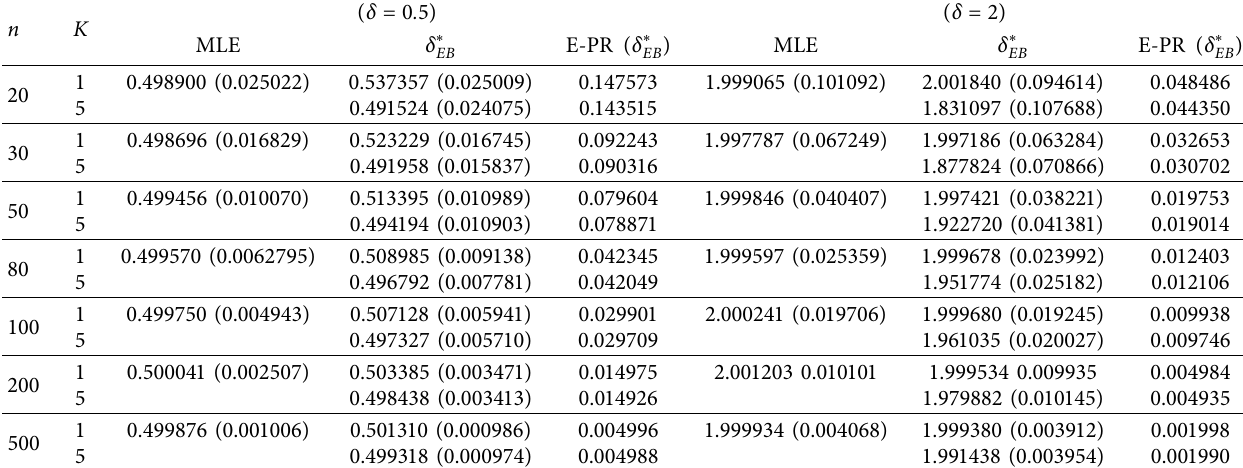
Table 6: E-B and E-PR estimates of PLF.